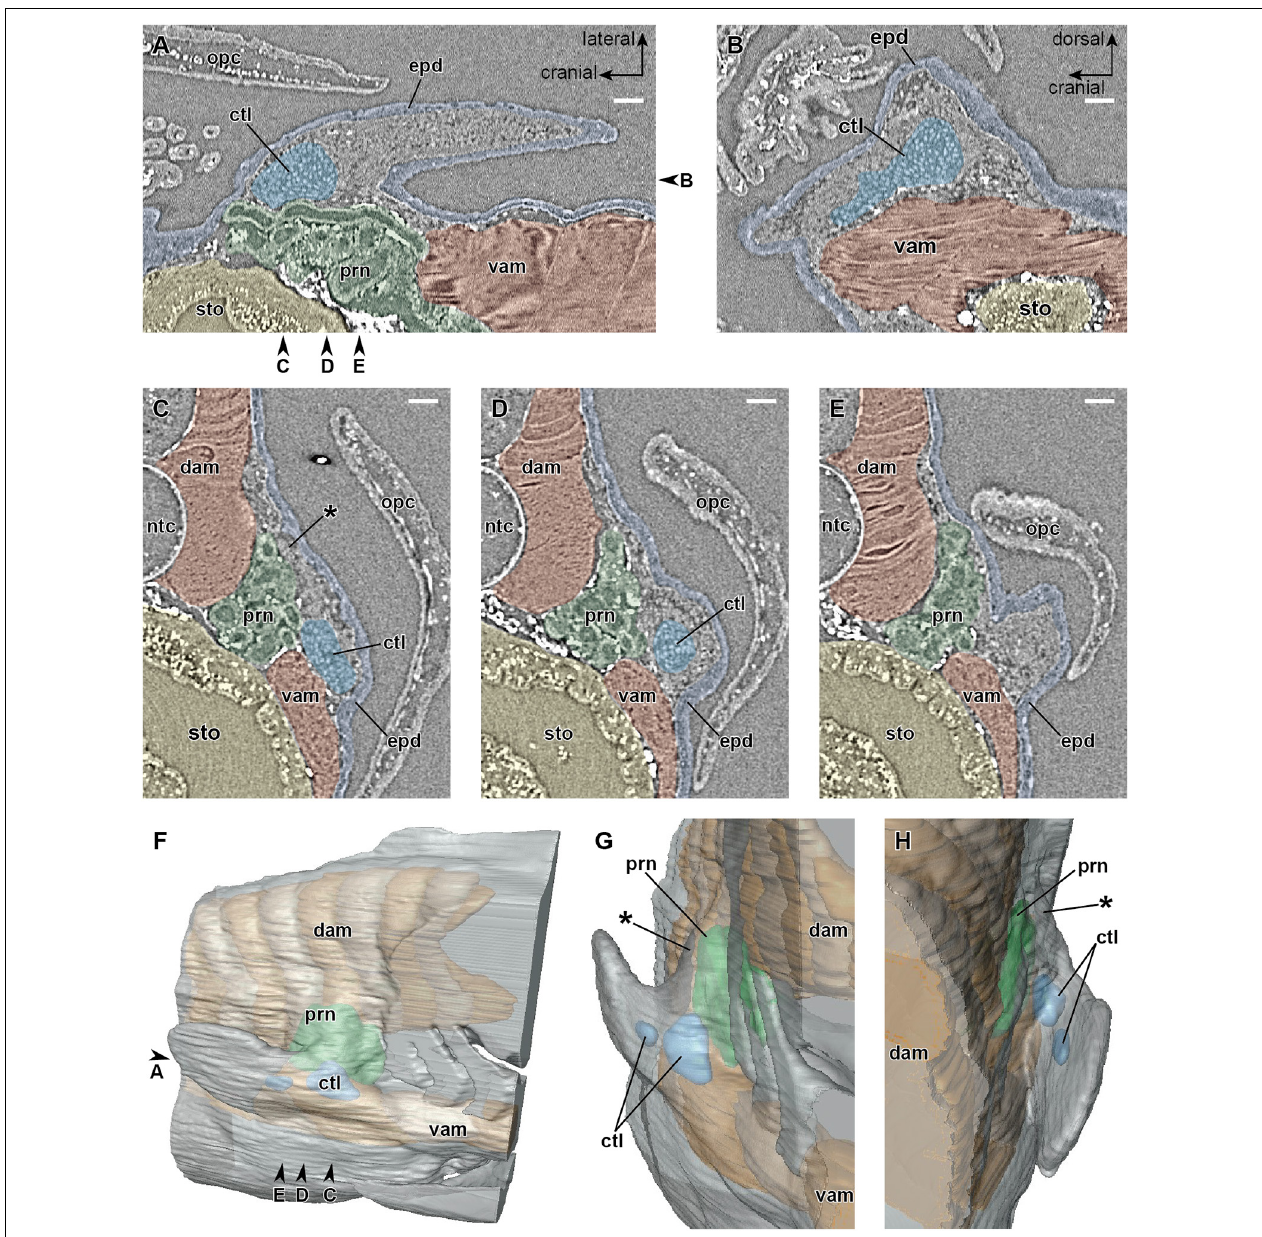
FIGURE 2 | Developing right pectoral fin of Neoceratodus forsteri during the early phase of stage 47 (total length = 16.0 mm). (A) Coronal section. (B) Sagittal section. (C–E) Transverse section. (F) Lateral view. (G) Cranial view. (H) Caudal view. ctl, cartilage; dam, dorsal axial muscle; epd, epidermis; ntc, notochord; opc, operculum; prn, pronephros; sto, stomach; vam, ventral axial muscle. Arrowheads indicate the respective sectioned levels. The asterisk marks the cranial part of the junction between the axial body wall and fin bud, filled by a small number of mesenchymal cells at this developmental stage, which later form the cleithrum. Scale bar = 100 µ